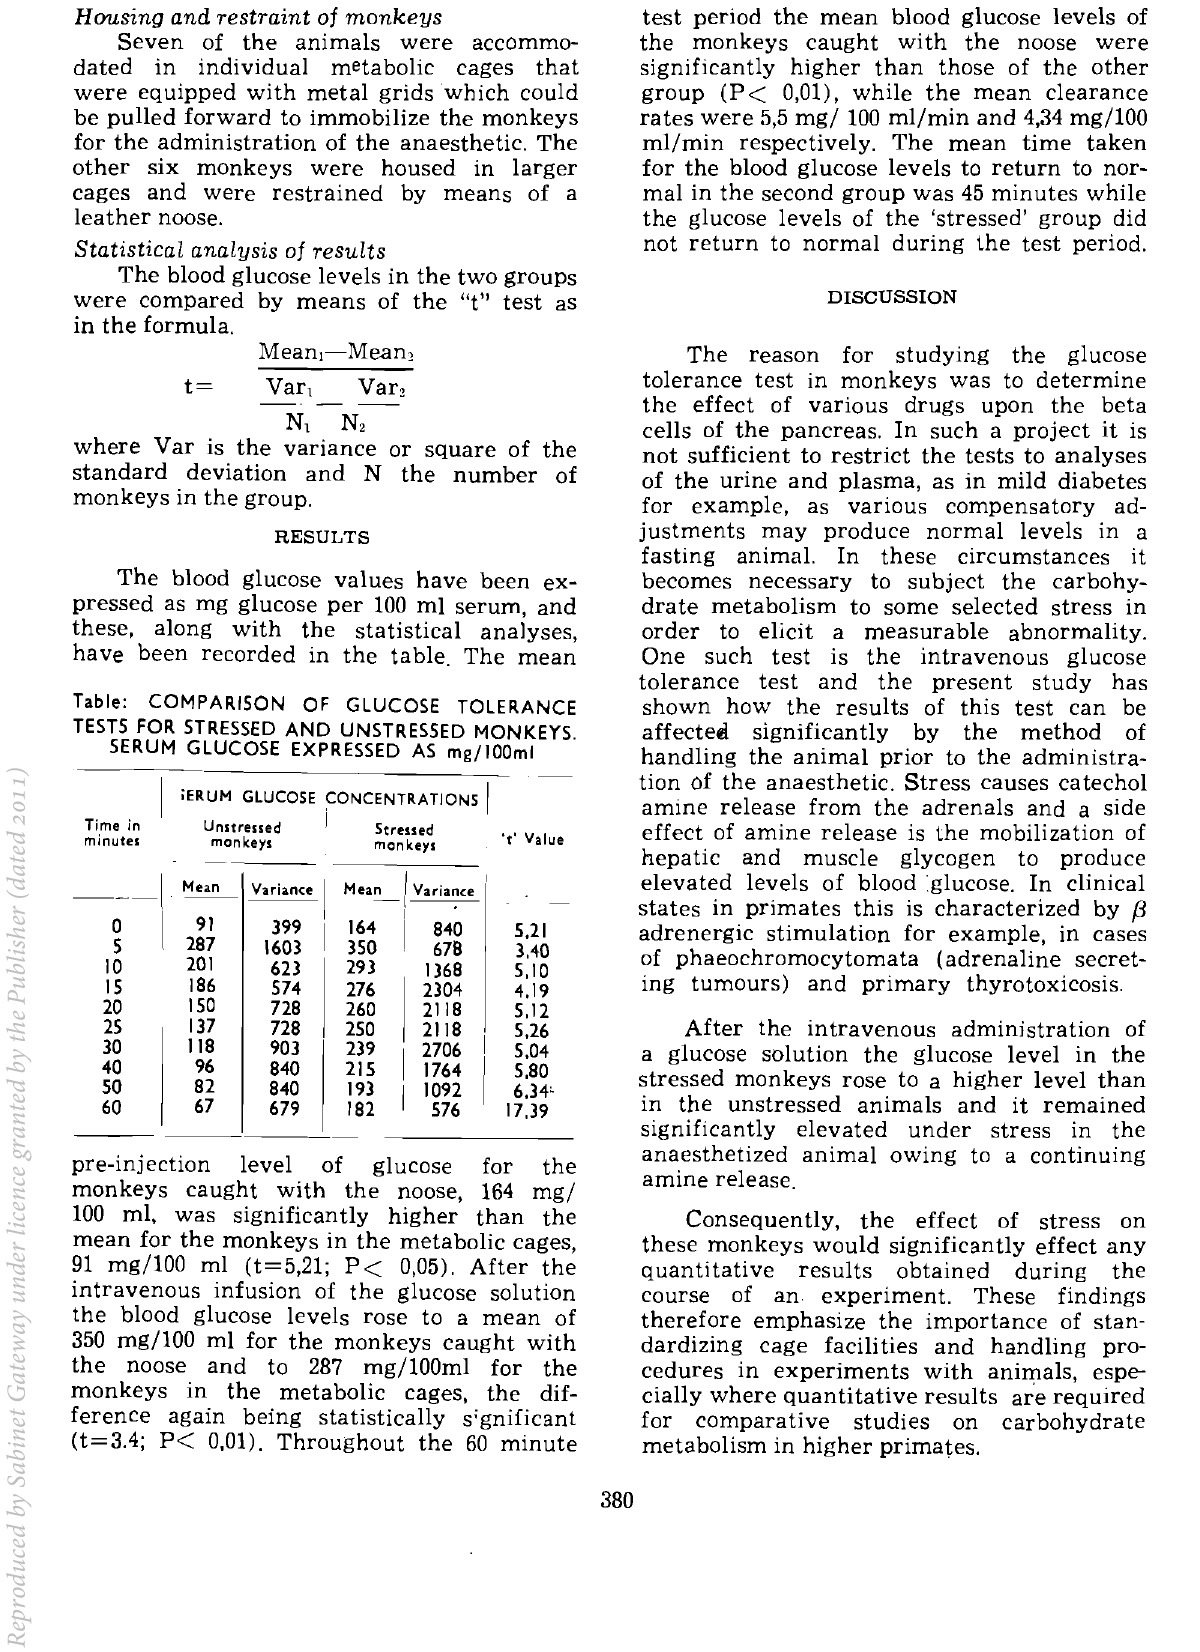
Table: COMPARISON OF GLUCOSE TOLERANCE TESTS FOR STRESSED AND UNSTRESSED MONKEYS, SERUM GLUCOSE EXPRESSED AS mg/lOOml iERUM GLUCOSE